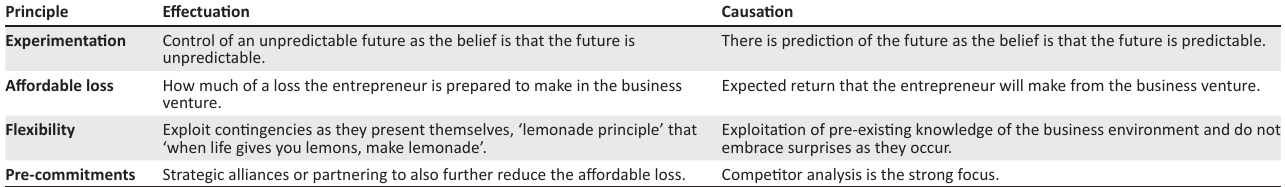
TABLE 1: Characteristics that define effectuation vs causation approach. Principle Effectuation